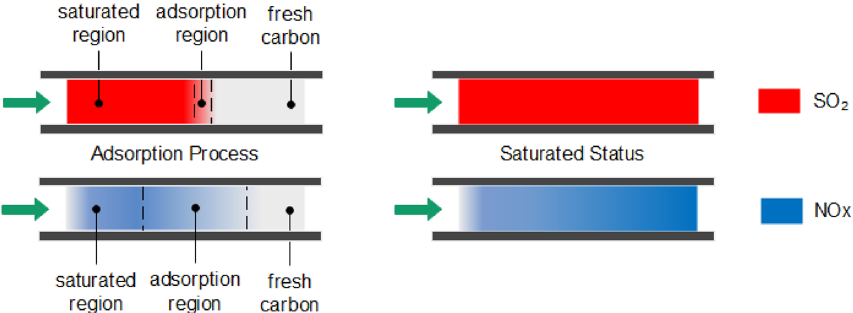
Figure 12. Adsorption process of SO 2 (red) and NO (blue) with presence of oxygen over activated